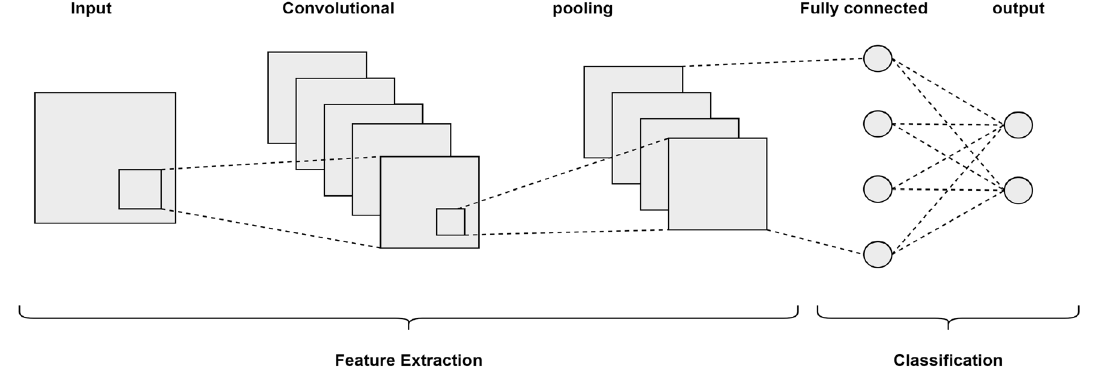
Fig. 2 Basic diagram for CNN. Source :